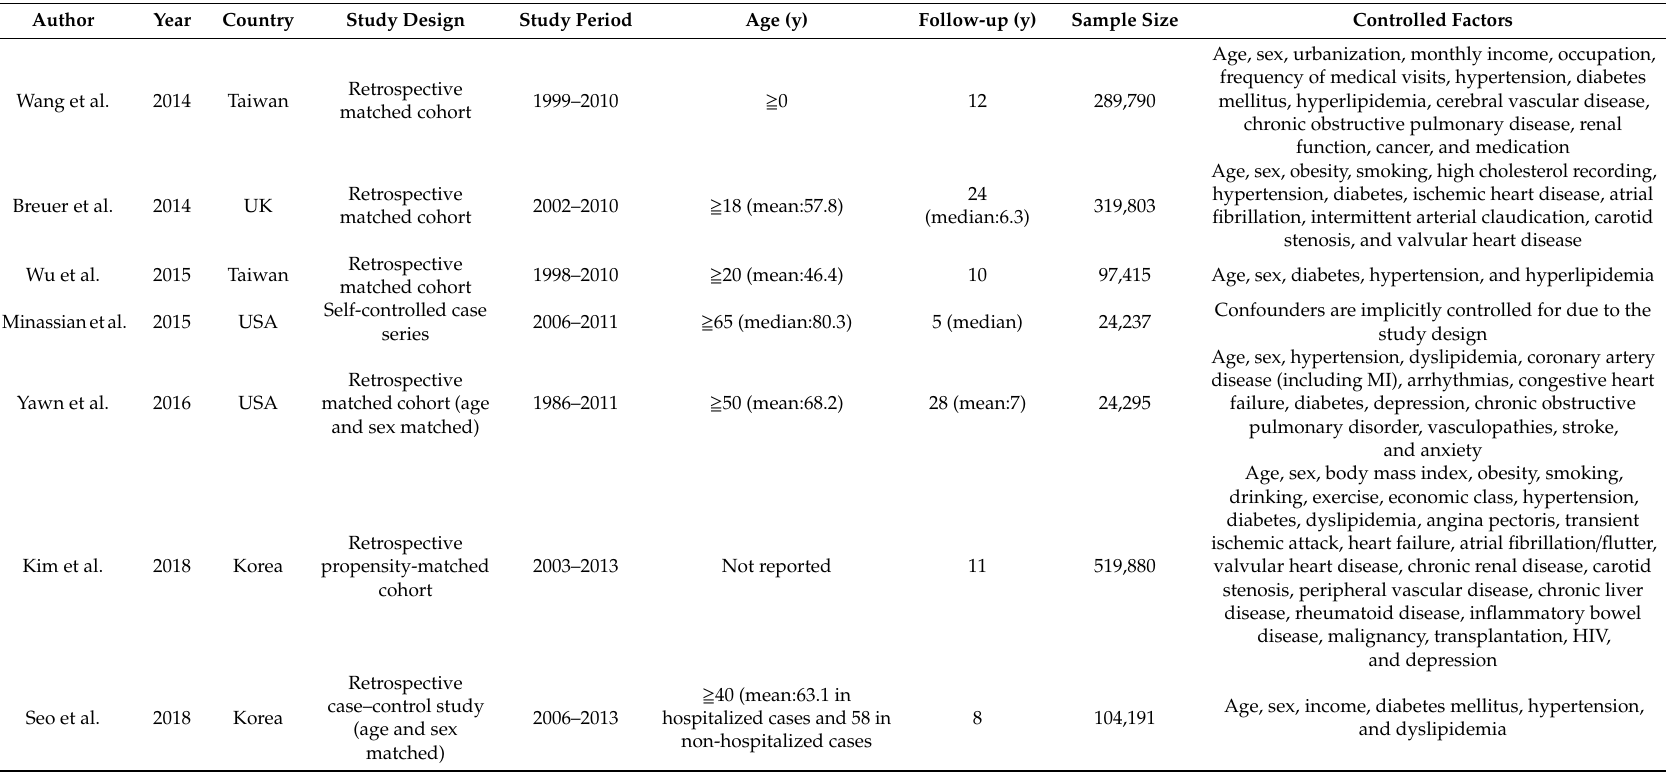
Table 2. Studies that investigated herpes zoster and the risk of myocardial